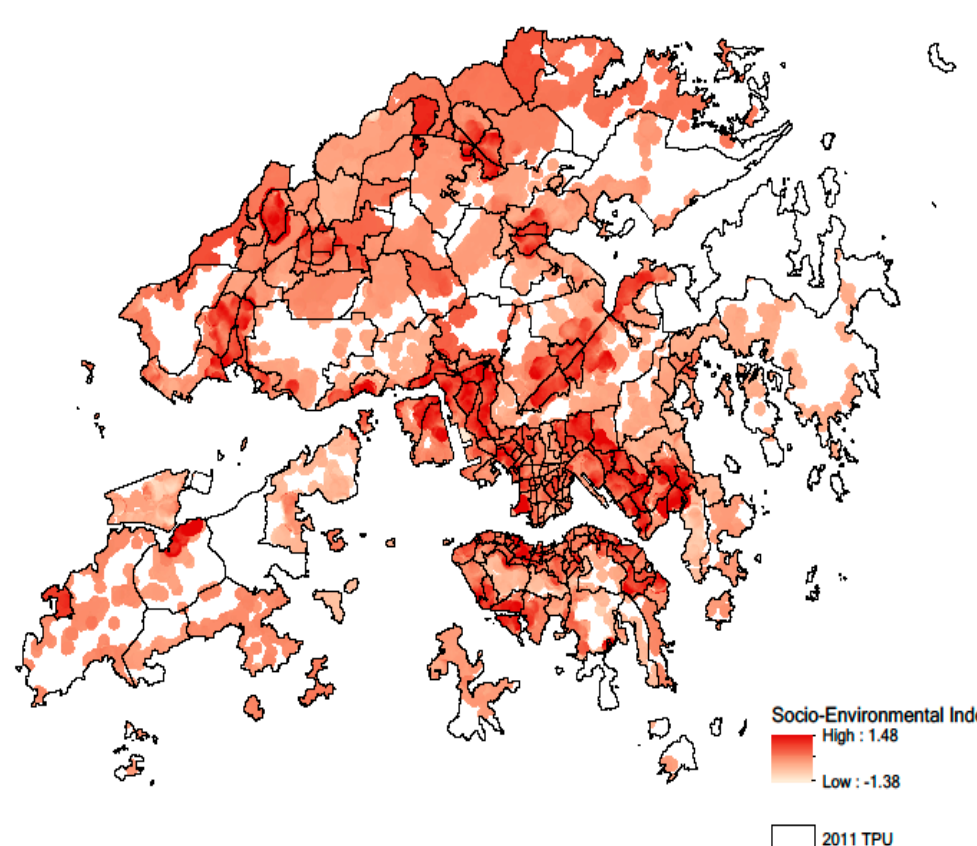
Figure 1. Socio-environmental vulnerability map showing the Tertiary Planning Unit (TPU) with different levels of geriatric depression risk. Note that areas without human settlements are in white color.